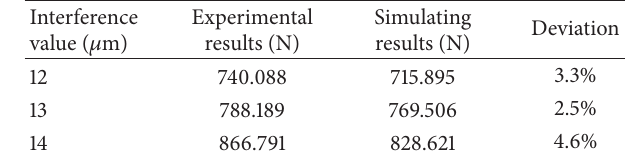
Table 8: Standard deviations of maximum press-mounting forces. Table 9: Comparison among maximum press-mounting forces.